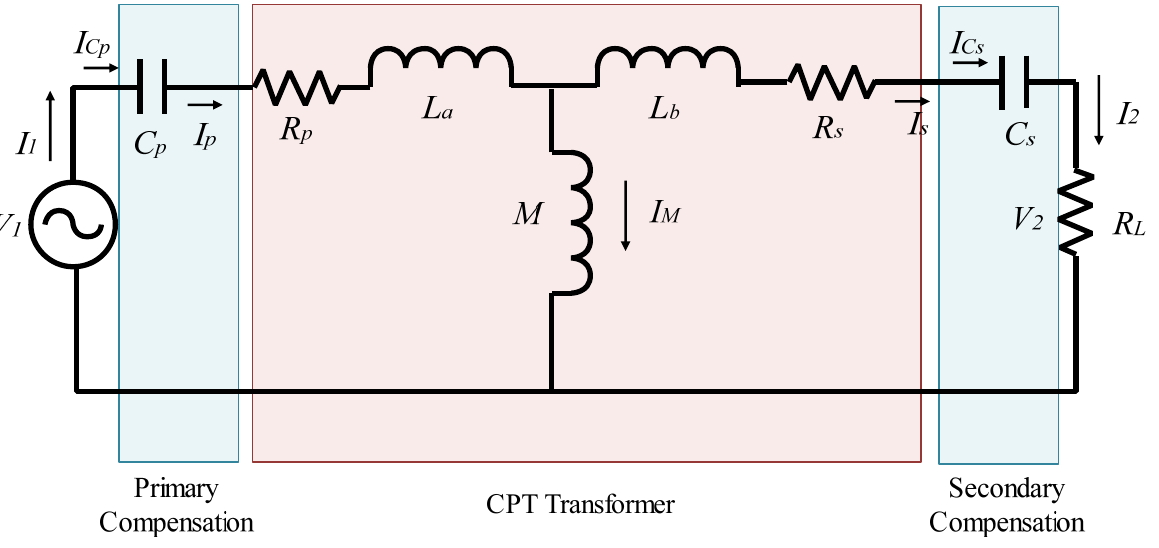
Figure 4. SS compensation topology design with R L load.